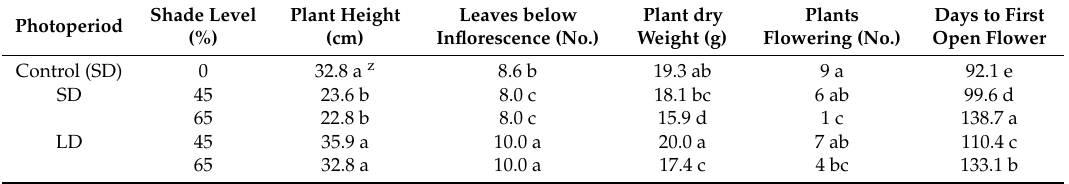
Table 1. Effects of light intensity treatments on plant height, number of leaves below inflorescence, plant dry weight, number of plants flowering, and days to first open flower in red firespike ( Odontonema strictum ). Plants were grown under 0%, 45%, or 65% shade under two photoperiod conditions; long-day (LD) or short-day (SD).